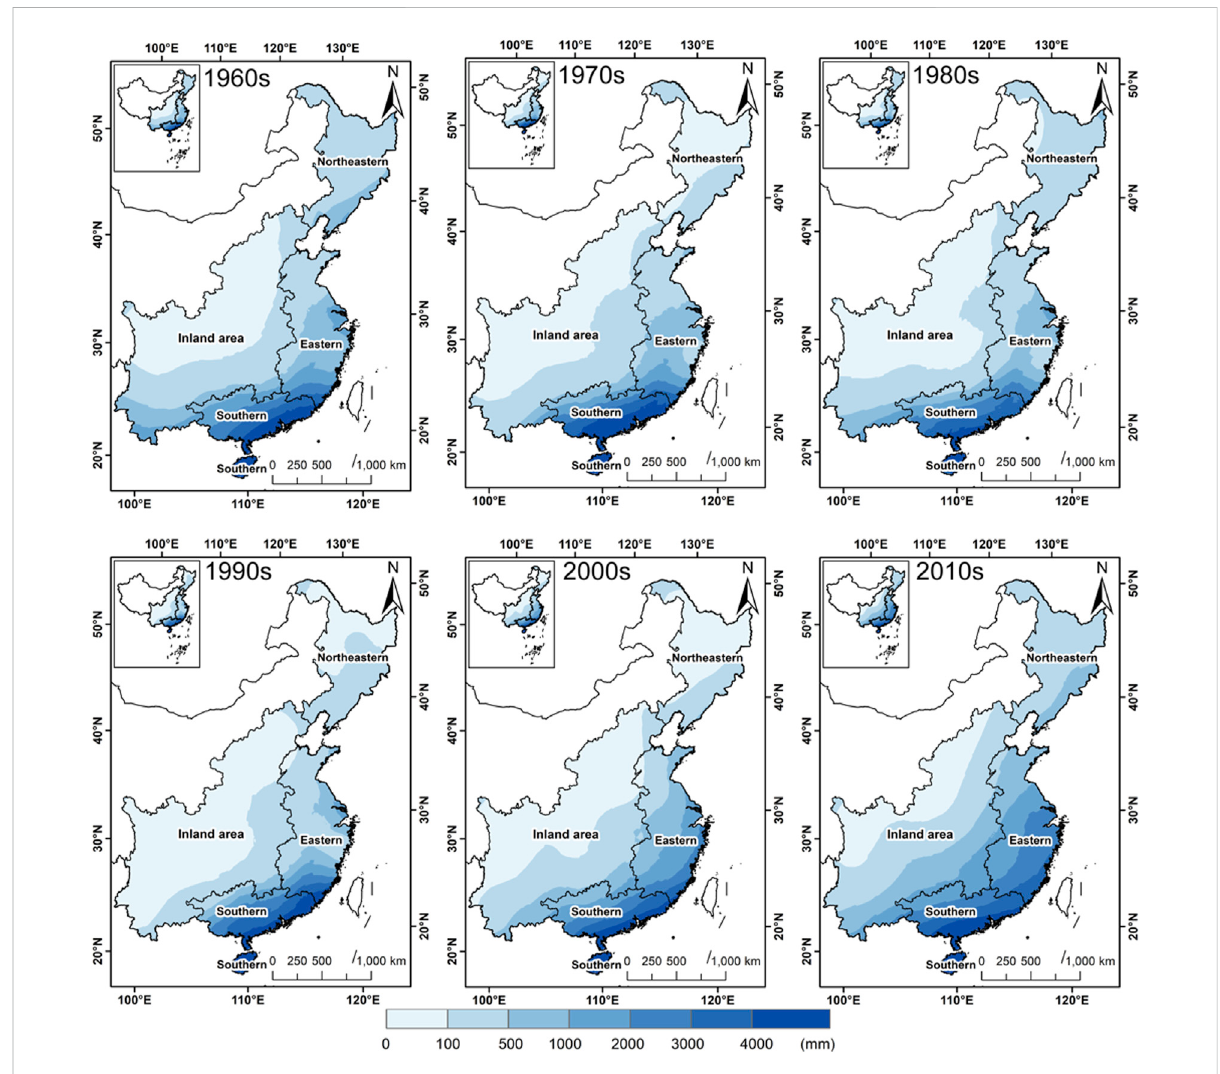
FIGURE 13 Interdecadal distribution of TCP over China from the 1960s –